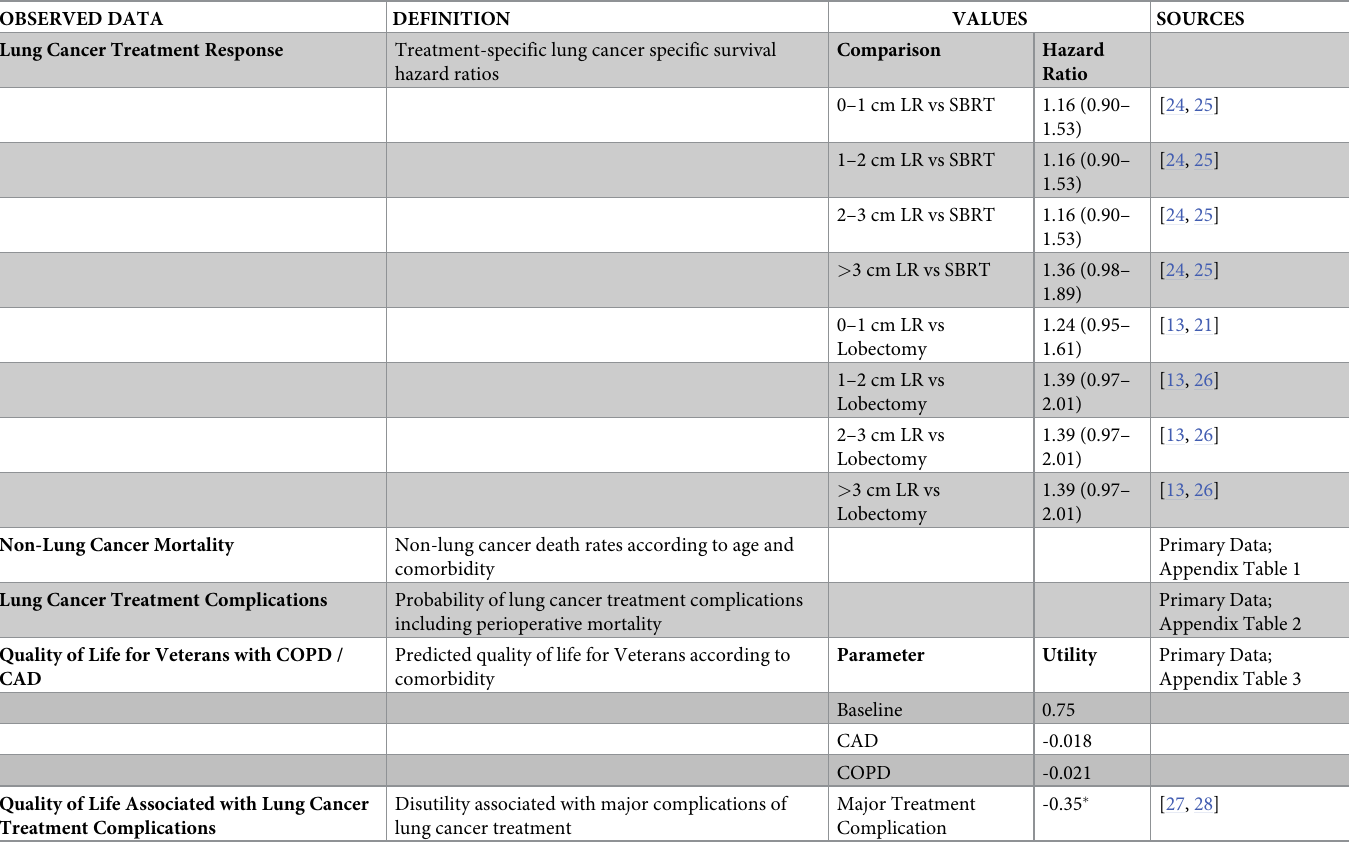
Table 1. Key input parameters for developing a microsimulation of veterans with lung